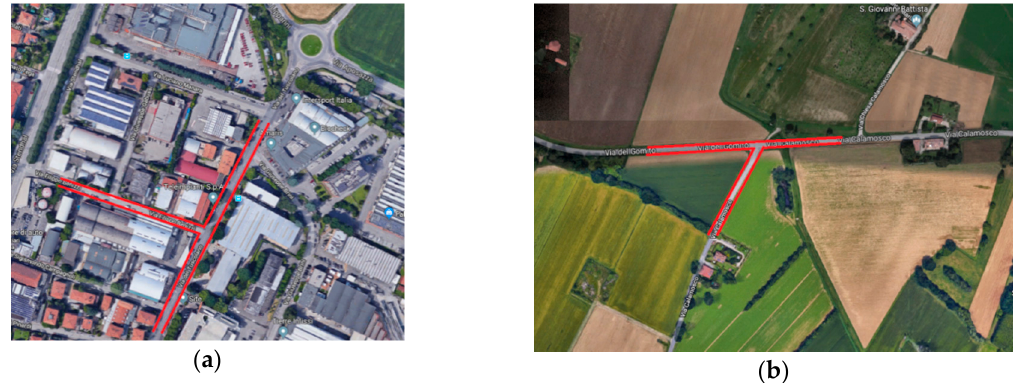
Figure 2. Intersections where the simulations took place, located in urban area ( a ) and in suburban area ( b ). (Coordinates 44°32’07.0”N 11°21’33.6”E for urban intersection and 44°31’38.2”N 11°23’38.0”E for suburban intersection).